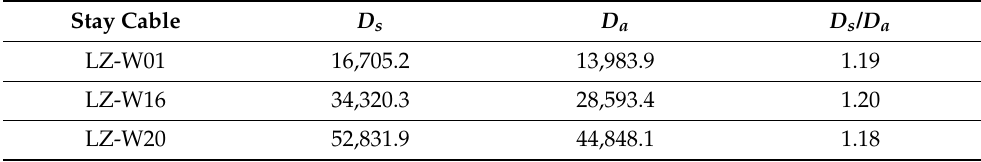
Table 11. Parameters D a and D s in year